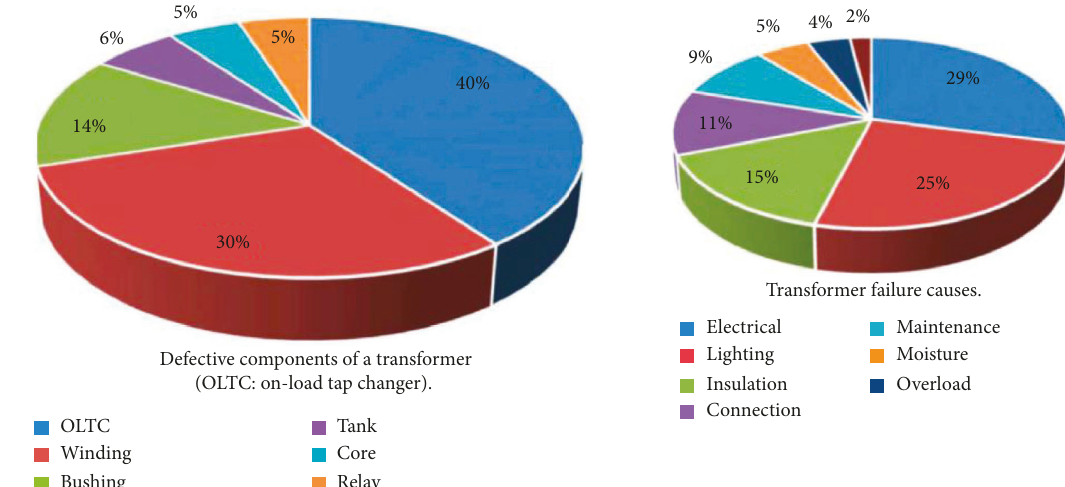
Figure 2: Defective components of a transformer and failure causes.